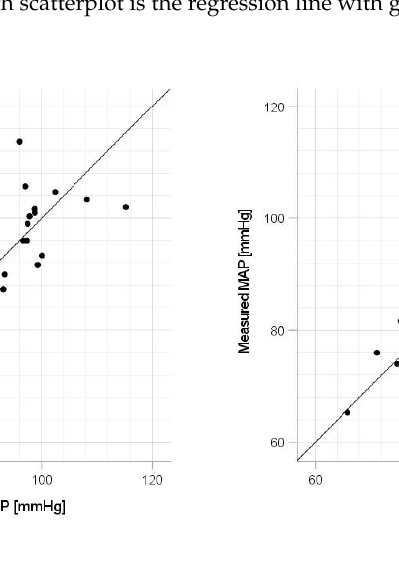
Figure 8. Accuracy of mean arterial pressure (MAP) estimation at each wavelength. Scatterplots of MAP estimated using proposed method and MAP measured with a cuff sphygmomanometer ( N = 42). From left to right, the light source wavelengths are blue (B), green (G), red (R), and near-infrared (NIR). The solid line on each scatterplot is the regression line with geometric mean regression.